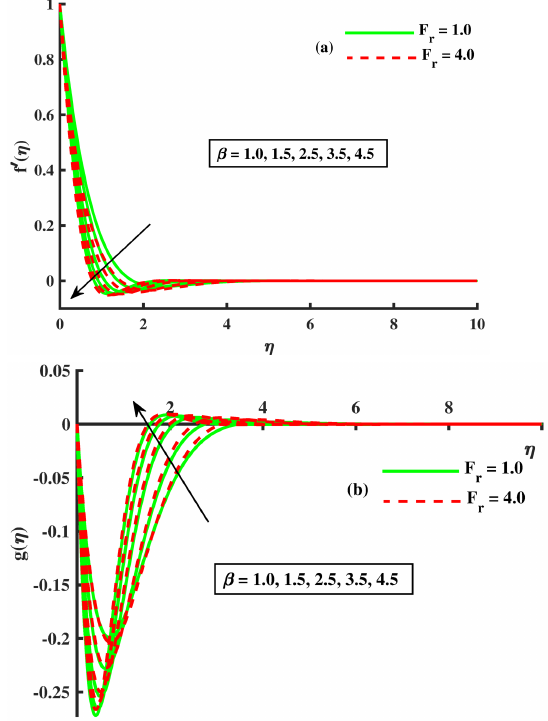
Figure 2. The effect of β & F r on f (cid:48) ( η ) & g ( η ).